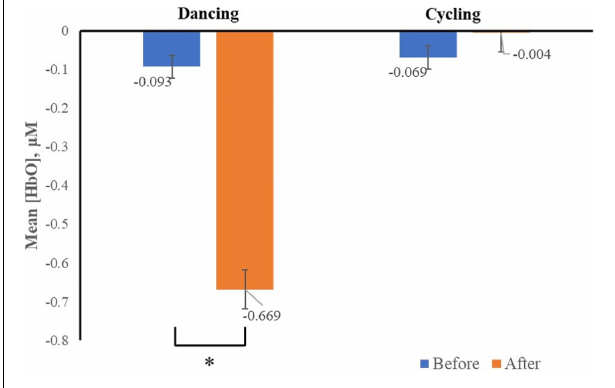
FIGURE 4 | Mean changes in oxyhemoglobin concentration (HbO), which represents neural activation, for channel two as participants viewed negative stimuli before and after acute exercise, by group. Channel two was positioned to capture activity in the dlPFC, bars represent participant means, and vertical lines represent standard errors of the mean. * p <